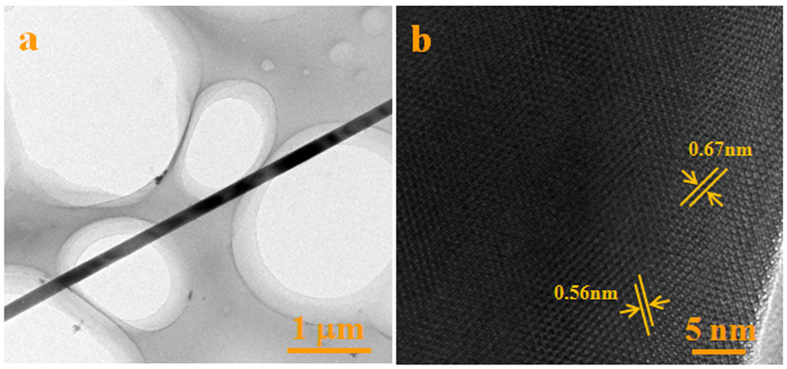
TEM and HRTEM images of a single Si3N4 NW obtained on the inner wall of ceramic crucible.